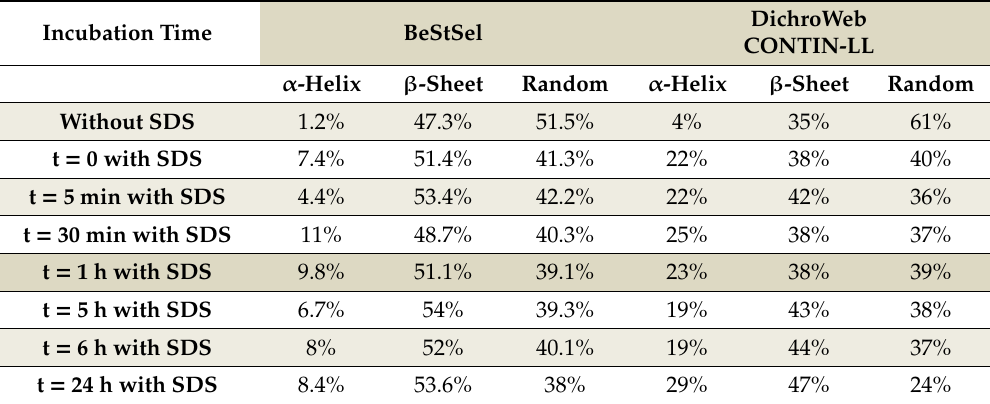
DichroWeb CONTIN-LL